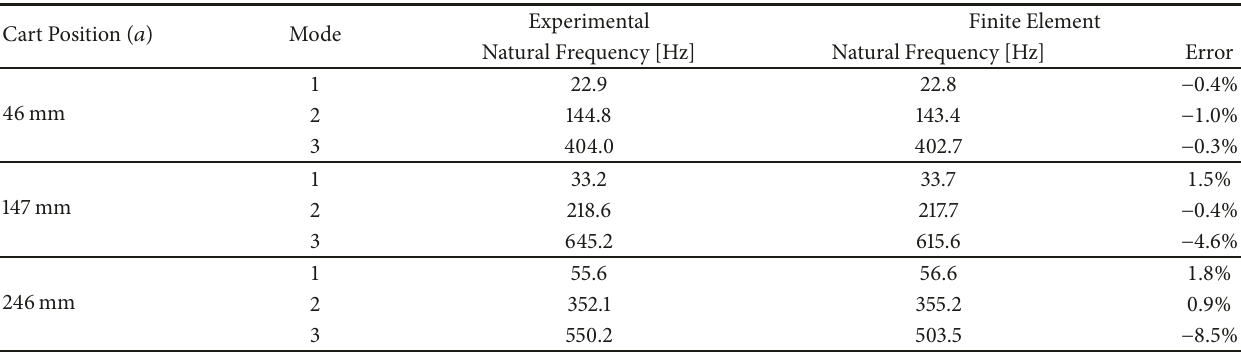
Table 2: Finite element and experimental natural frequencies for the DROPBEAR with the rollers at distances from the clamped end ( 𝑎 ) of 46mm, 147mm, and 246mm. Percent errors are relative to the experimentally obtained natural frequencies.